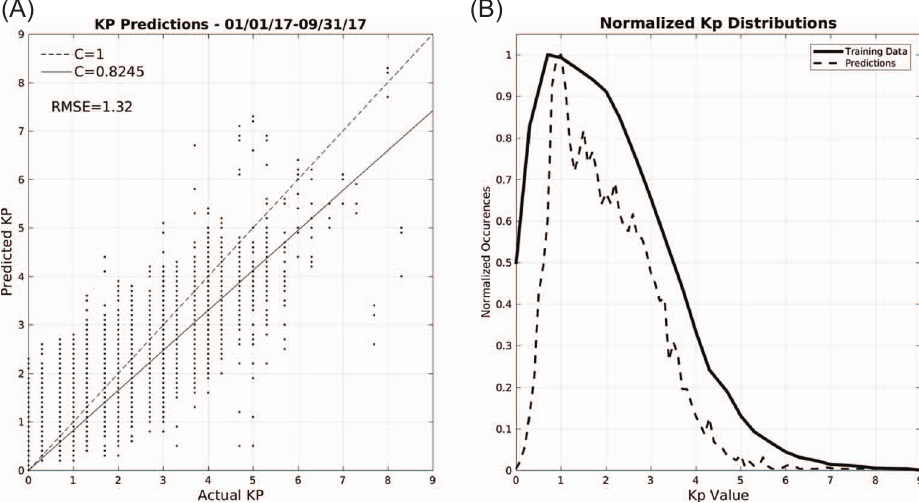
Fig. 5. (A) 6528 Kp predictions 01/01/2017 – 09/30/17 from a network trained on the original Wing model inputs: B z , n , V , | B |. (B) Frequency of Kp values for full data set 1986 – 2016 and 2017 predictions. The model consistently predicts Kp values lower than the actual measured values.